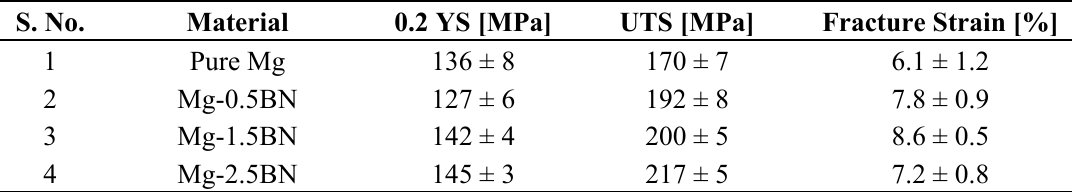
Table 5. Results of room temperature tensile